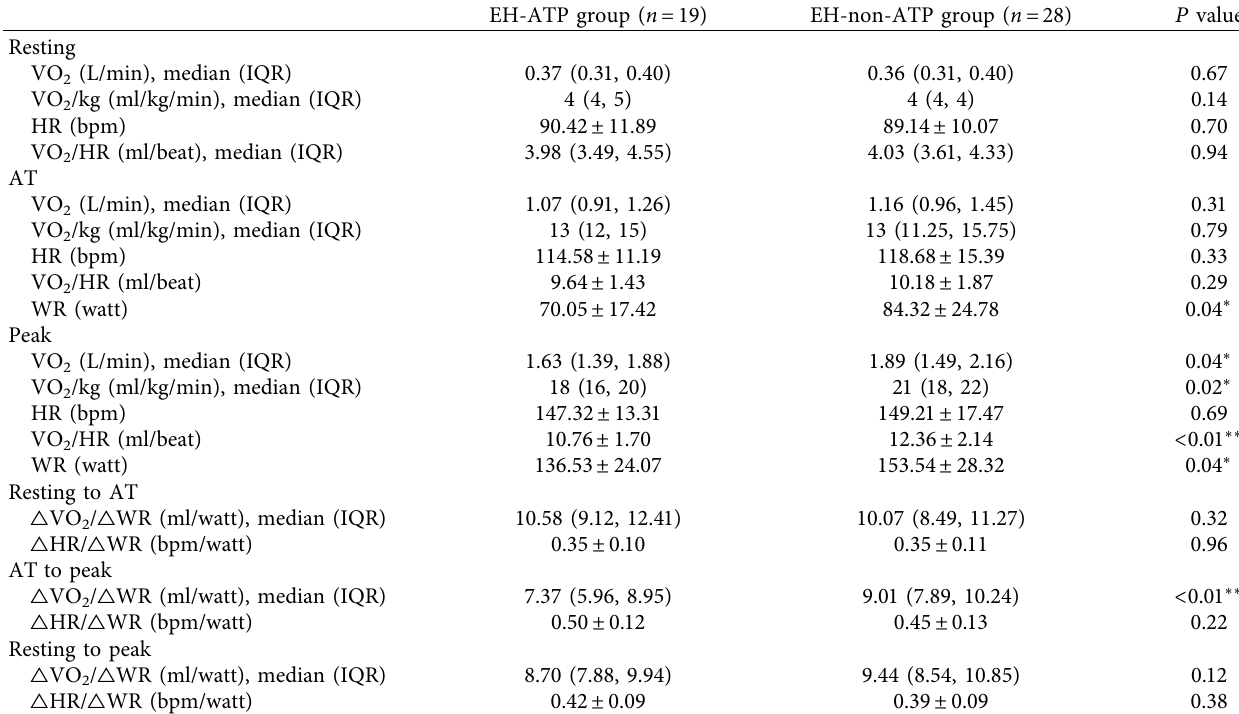
Table 5: Comparison of CPET parameters between EH-ATP group and EH-non-ATP group.